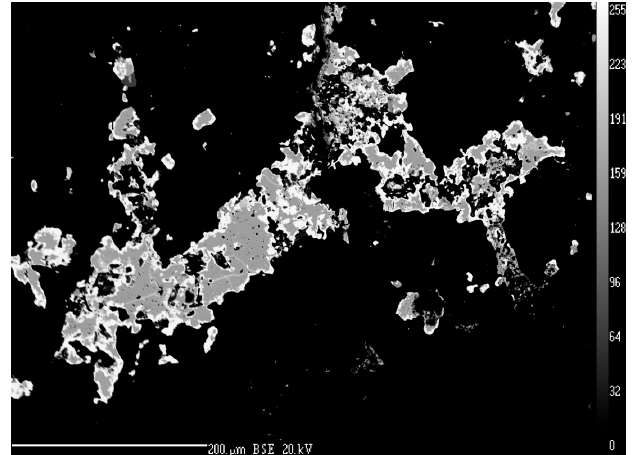
Figure 43. Permingeatite anhedral grains (grey) rimmed by clausthalite (white). BSE photograph. P ř íbram, a dump of shaft 16. Photo by J. Sejkora and P. Škácha.